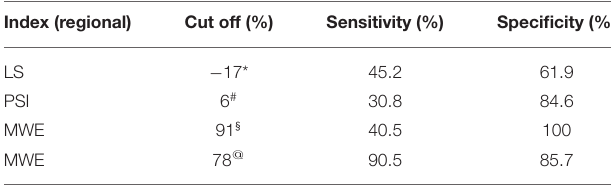
FIGURE 3 | The chart shows that regional MWE, measured within the FRA (underlying the target vessel with CAST), was decreased by 21% ( p < 0.001) compared to the NRA of the same patients, while no significant change was found for LS ( p = 0.476), nor for PSI ( p = 0.129). MWE, Myocardial Work Efficiency; CAST, critical coronary stenosis; LS, Longitudinal Strain; FRA, functional risk area; NRA, non-risk area; PSI, post-systolic shortening index.